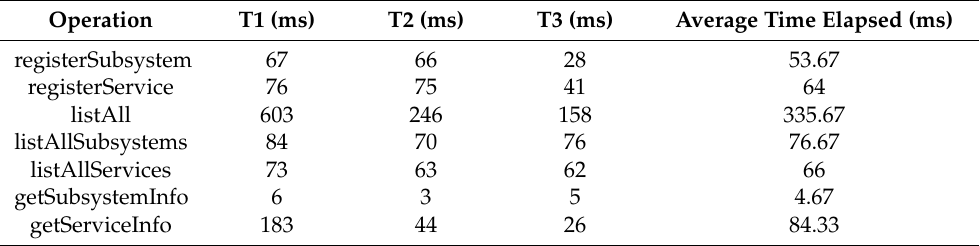
Table 5. Response time when there are 500 subsystems and services registered.